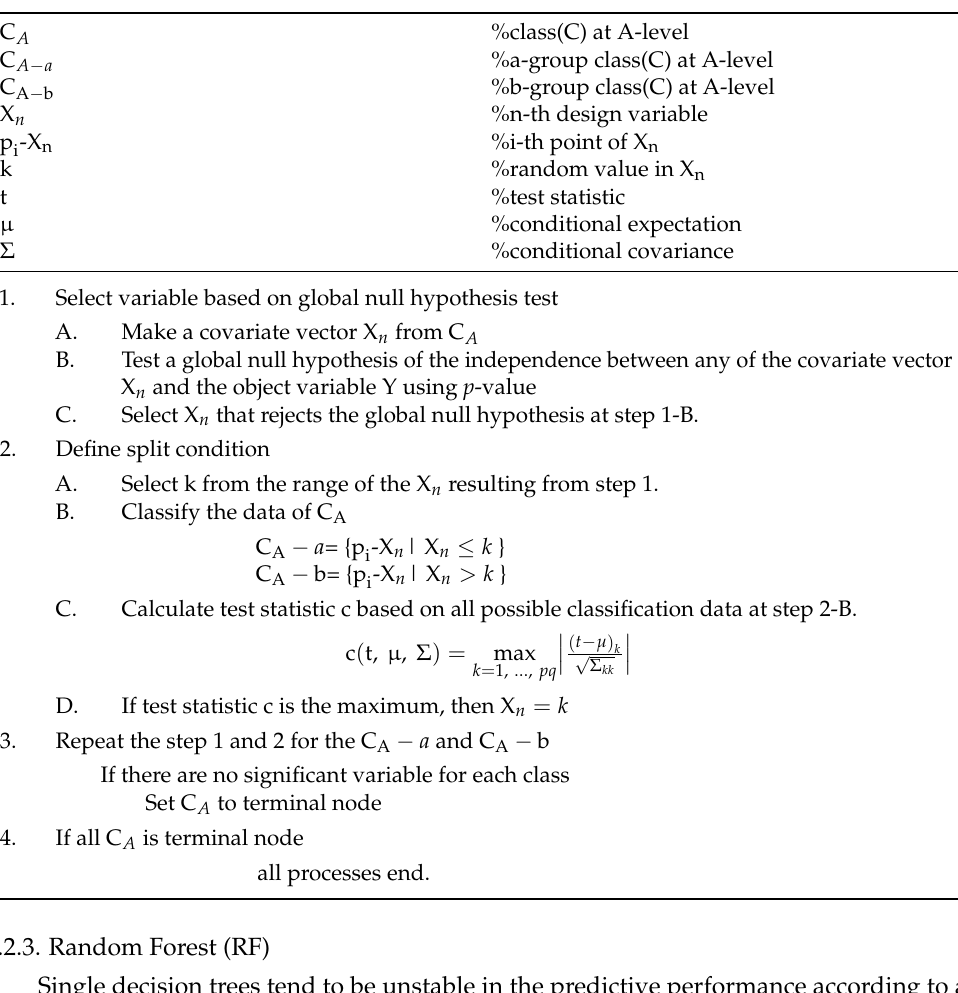
Table 3. CIT pseudocode (summarized from